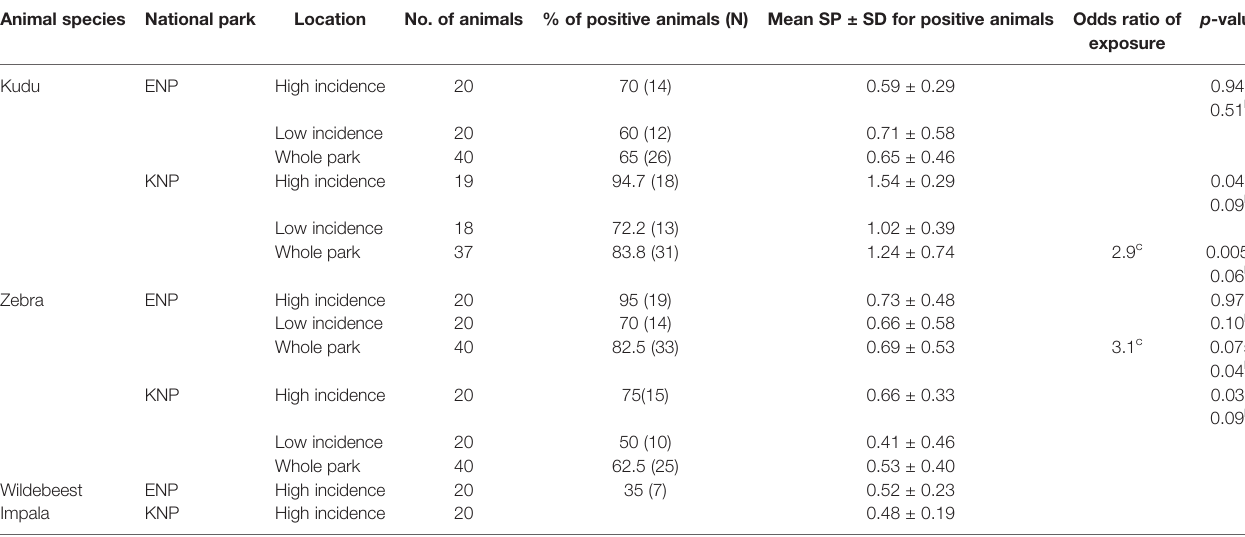
TABLE 1 | Differences in host exposure to Bacillus anthracis by species and location, assessed through anti-protective antigen (PA) antibodies. Animal species National